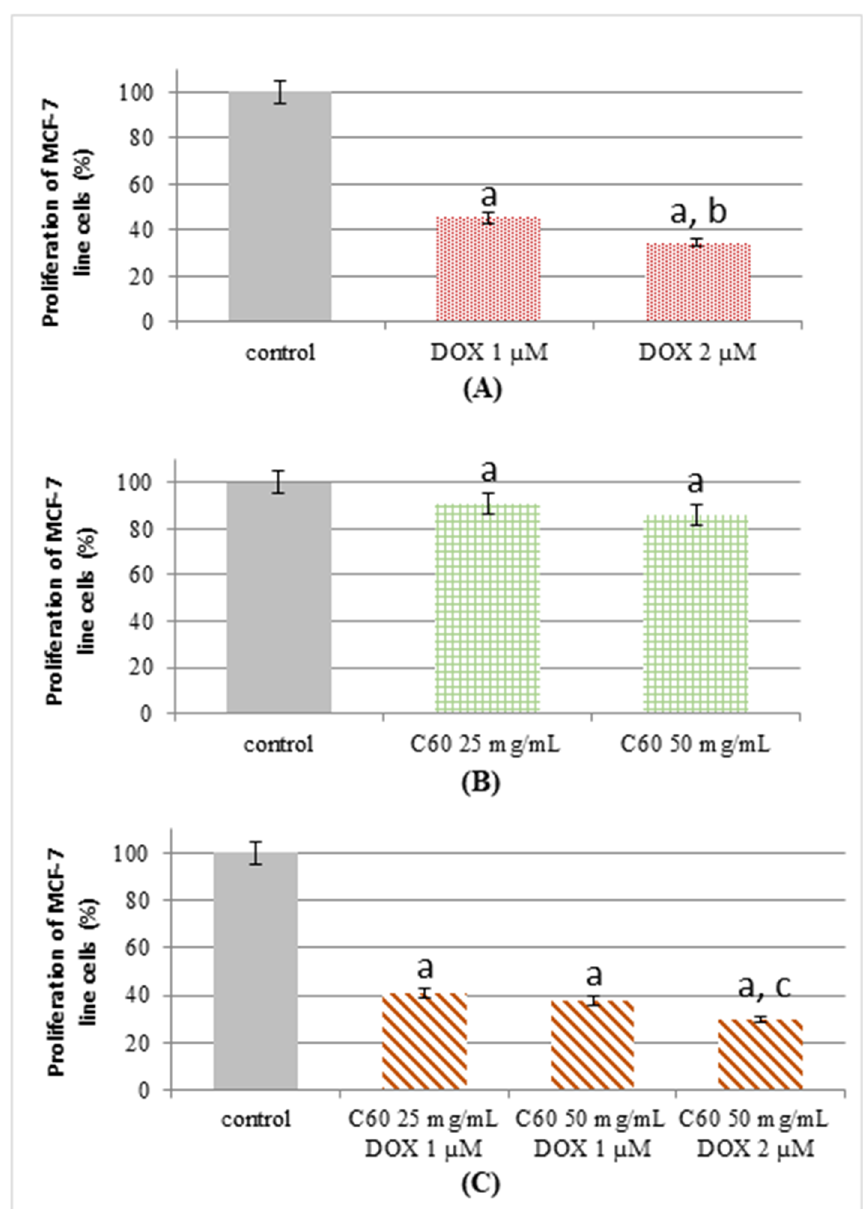
Figure 2. Proliferation of MCF-7 cells. Proliferation of MCF-7 cells treated by ( A ) DOX, (B) C 60 , (C) complexes of C 60 –DOX. For other experimental conditions, see Material and Methods. a p < 0.05 when compared to control cells; b p < 0.05 when compared to cells treated by 1 µM DOX; c p < 0.05 when compared to cells treated by C 60 –DOX complexes (25 mg/mL C 60 -1 µM DOX and 50 mg/mL C 60 -1 µM DOX).